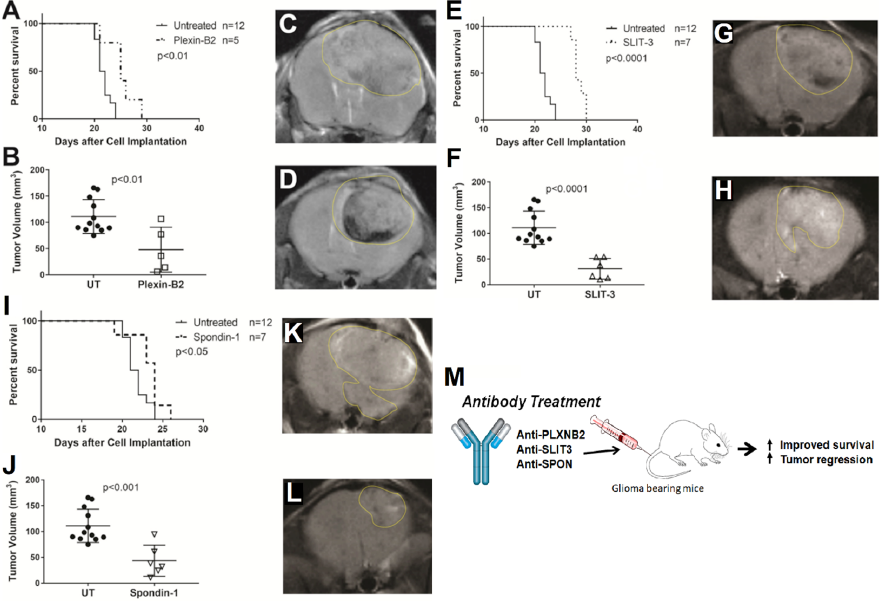
Figure 2. Antibodies against PLXNB2, SLIT3, or SPON1 are effective against GL261 orthotopic tumors. Common untreated data sets were used to compare each antibody treatment separately.